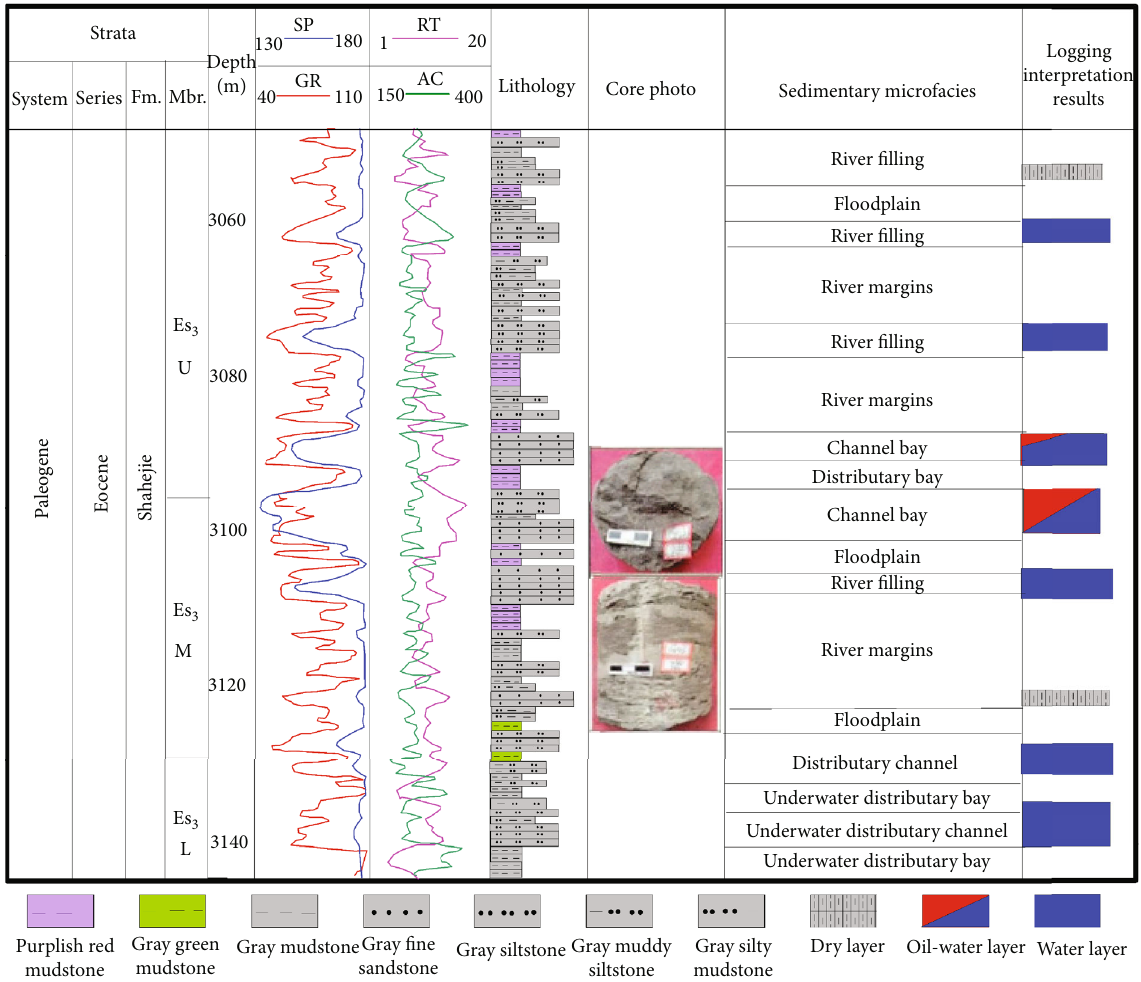
Figure 3: Composite column of the 3rd members of the Palaeogene Shahejie Formation in the XA block. Table 1: Core analysis data statistics of Es